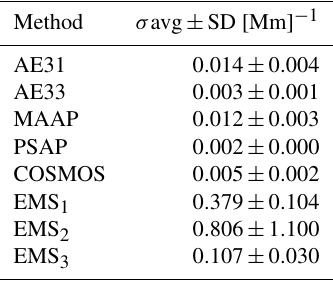
Table 2. The Allan deviation σ of absorption coefficient σ AP , 637nm measured with different methods between 1–2h averaging time (average ± standard